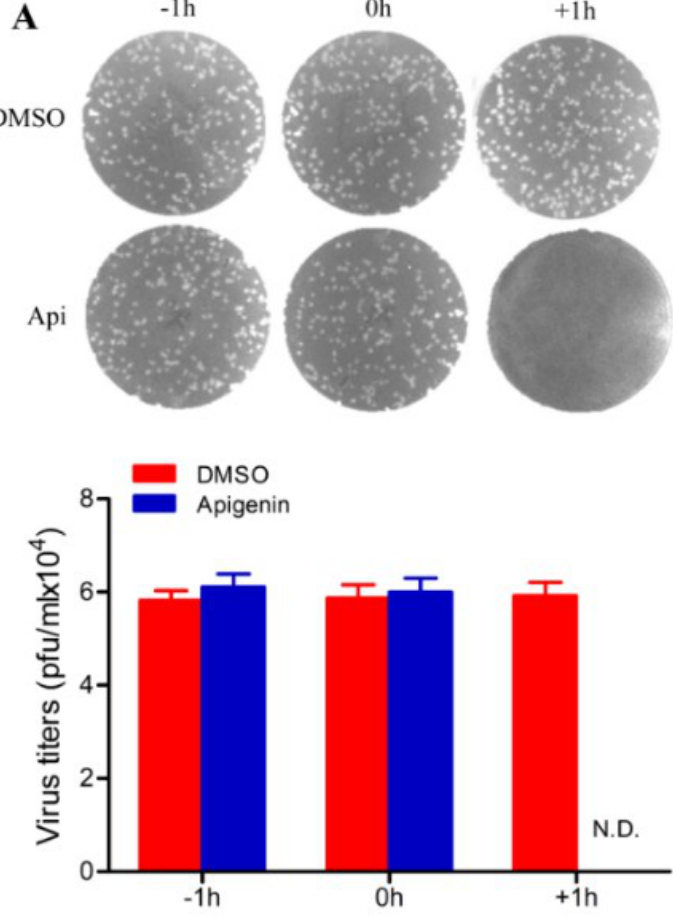
Figure 2. Time-of-drug-addition assay. BHK-21 cells were infected with FMDV at an MOI of 0.1 and then exposed to apigenin (20 µg/mL) at specific time points. −1 h: pre-infection 1 h. 0 h: during-infection. +1 h: post-infection 1 h. Apigenin exhibited a high inhibition rate at the post-infection stage. ( A ) Plaque reduction assay of apigenin; ( B ) FMDV viral